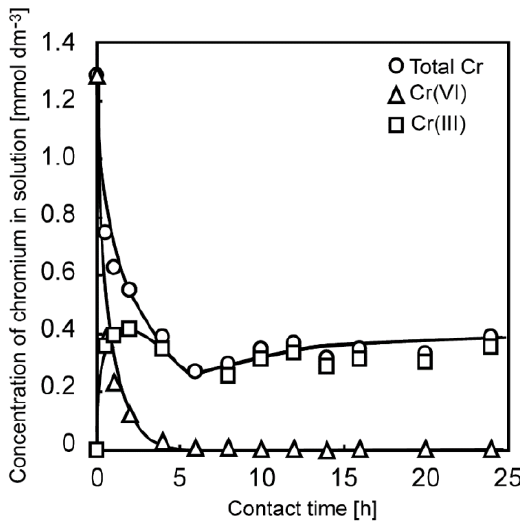
Figure 10. Time variation of the concentrations of chromium(VI) and chromium(III) as well as total chromium in the aqueous solution at pH = 1 during adsorption [23] (with permission for reuse from Elsevier B.V.).